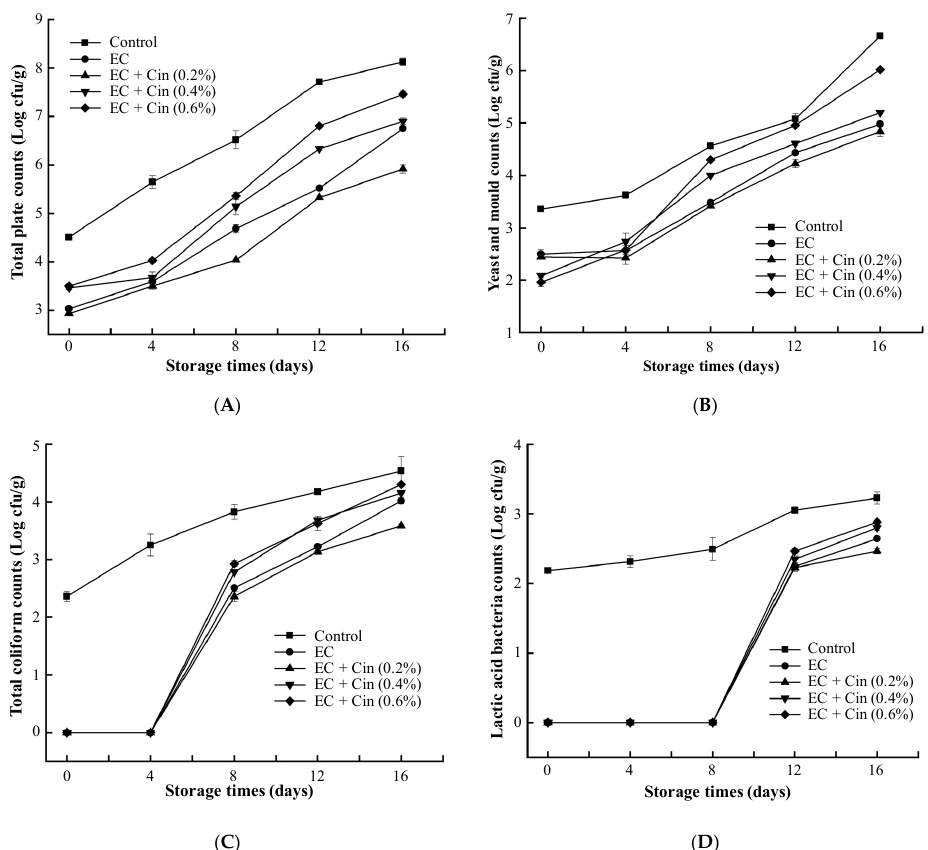
Figure 5. Population of naturally occurring microorganisms on fresh-cut potatoes coated with chitosan-based EC containing cinnamon oil. ( A ) Total plate counts; ( B ) yeast and mould counts; ( C ) total coliform counts; ( D ) lactic acid bacteria counts. Control: uncoated; EC: edible coating; Cin: cinnamon oil. Bars represent means ± SD ( n = 3, p < 0.05).